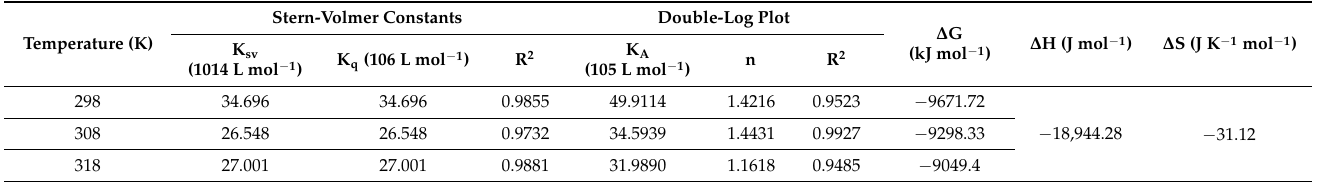
Table 3. Stern-Volmer constants and thermodynamic parameters of dHPI+HSE complex at different